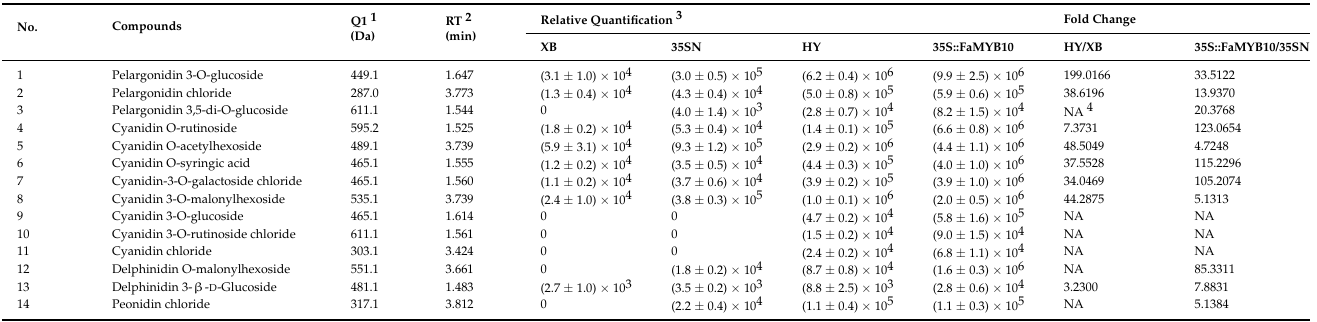
Table 1. Flavonoid compounds in the flesh of Benihoppe (HY), Xiaobai (XB), 35S::FaMYB10, and 35SN by targeted